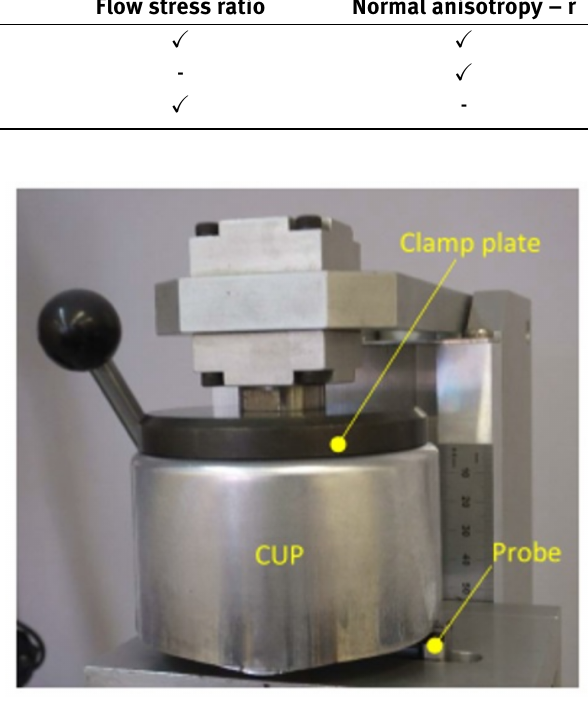
Figure 5: Ear measurement [19]